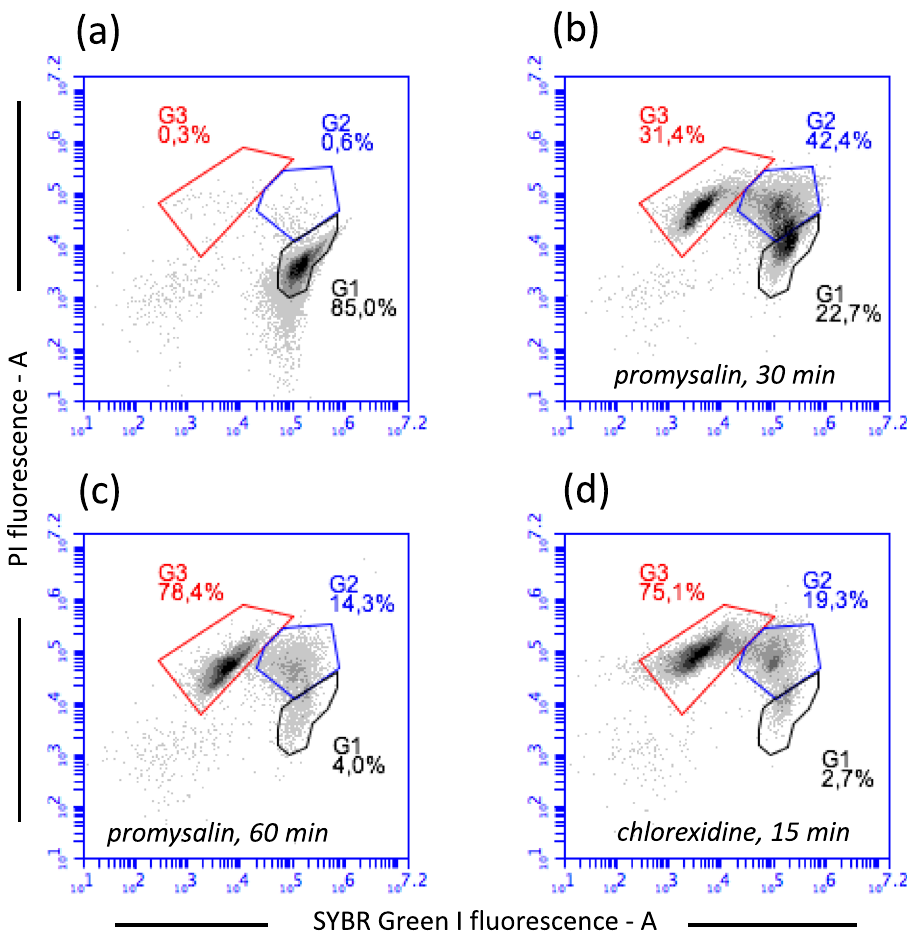
Figure 1. The effect of promysalin and chlorhexidine on S. thermophilus DSM 20617 T cell membrane integrity. Flow cytometry density diagrams show the SYBR Green I vs PI fluorescence of cells exposed to promysalin or chlorhexidine (100 µ g/ml respectively). ( a ) Cells before the exposure to the antibacterial molecule. ( b – d ) Cells after the exposure to the antimicrobial molecule. Viable cells are gated in G1, viable cells with slightly damaged cell membrane are gated in G2. Dead cells with damaged membrane are gated in G3. The transition of cell population from gate G1 to gate G3 is related to the entity of cell membrane